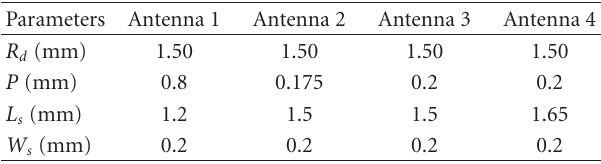
Antenna 3 with HFSS Antenna 3 with CST Antenna 4 with Antenna 4 with CST Figure 9: Comparison of the reflection coe ffi cient magnitude for antenna 3 and antenna 4 with CST and Ansoft HFSS. Table 1: Optimized parameters for antenna 1, antenna 2, antenna 3, and antenna